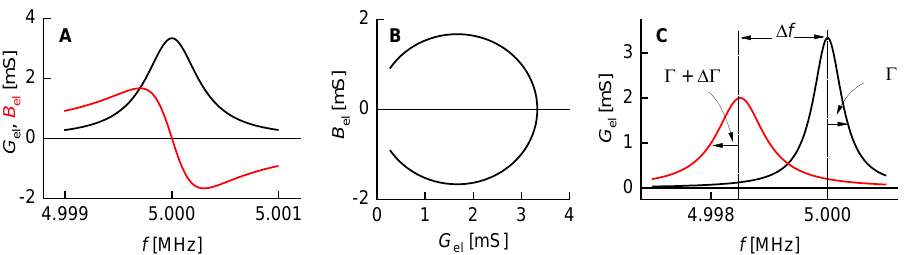
Figure 3. A typical output from impedance analysis. Panel ( A ) shows the conductance G el (black) and the susceptance, B el (red). Together, they form the complex electrical admittance, (cid:101) Y el = G el + i B el , which is equal to (cid:101) Z − 1 with (cid:101) Z el the impedance. The real part of the admittance forms the well-known, symmetric resonance curve (assuming perfect calibration). This is different for the real part of (cid:101) Z el because of the parallel electrical capacitance, C 0 . G el ( f ) peaks at the series resonance frequency, f res . Panel ( B ) shows the polar diagram. Of interest in sensing are the shifts in frequency and bandwidth, ∆ f and ∆Γ ( C ).